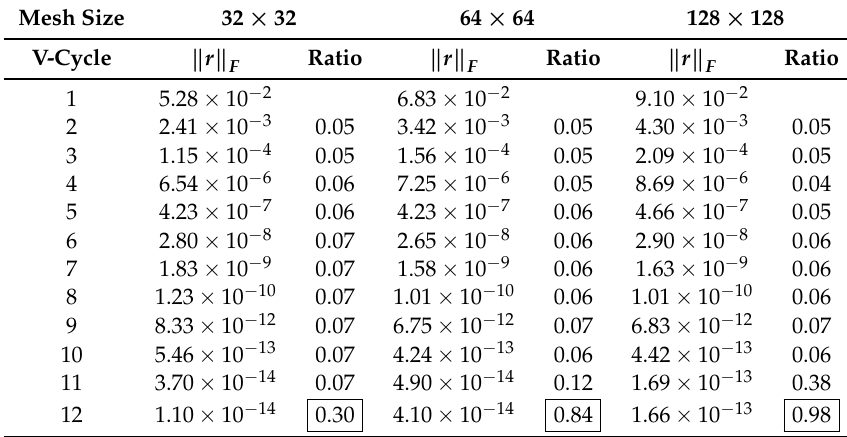
Table 1. Error and convergence results for various grid